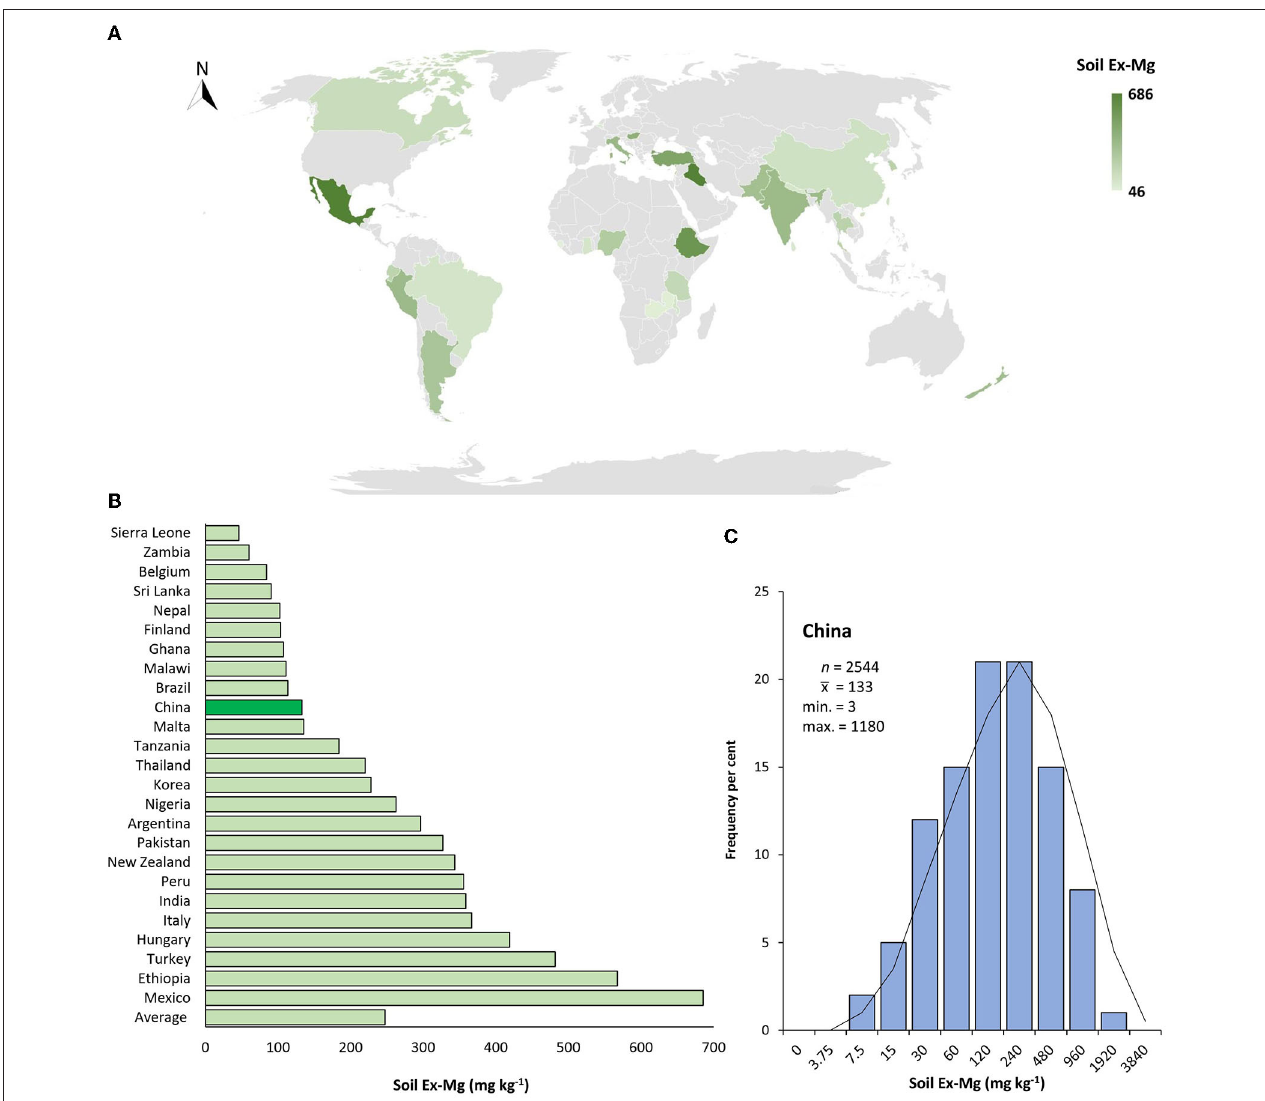
FIGURE 4 | Geographical distribution of soil Ex-Mg in agricultural systems. (A) Global soil Ex-Mg status for data available countries, (B) Global ranking of soil Ex-Mg for data available countries (value for China is highlighted by the dark green bar), (C) Frequency per cent of soil Ex-Mg in China’s farming systems. Gray color in map indicated data not